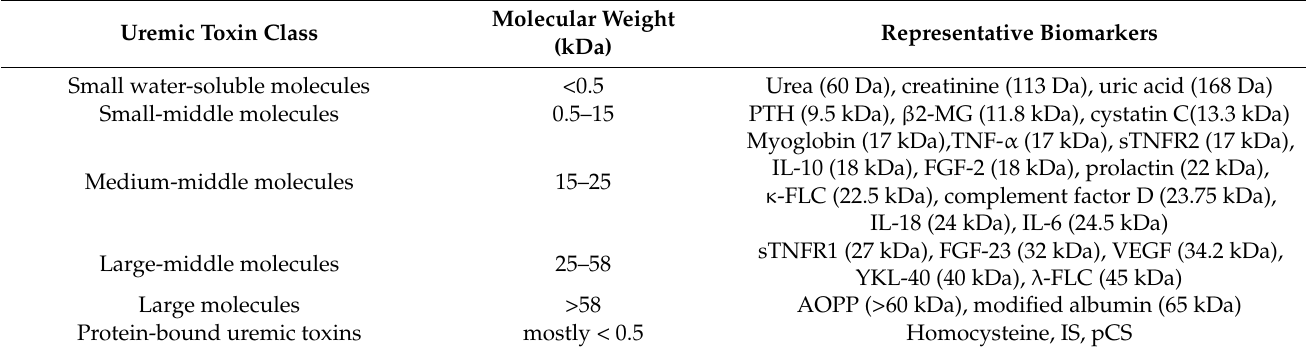
Table 1. Classification of uremic toxins and their representative biomarkers,